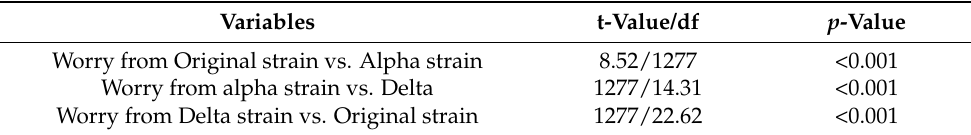
Figure A1. Monthly distribution of the HCWS vaccination of COVID-19 according to the responses. Table A1. Bivariate paired samples t-test comparing HCW’s worries from various COVID-19 strains.